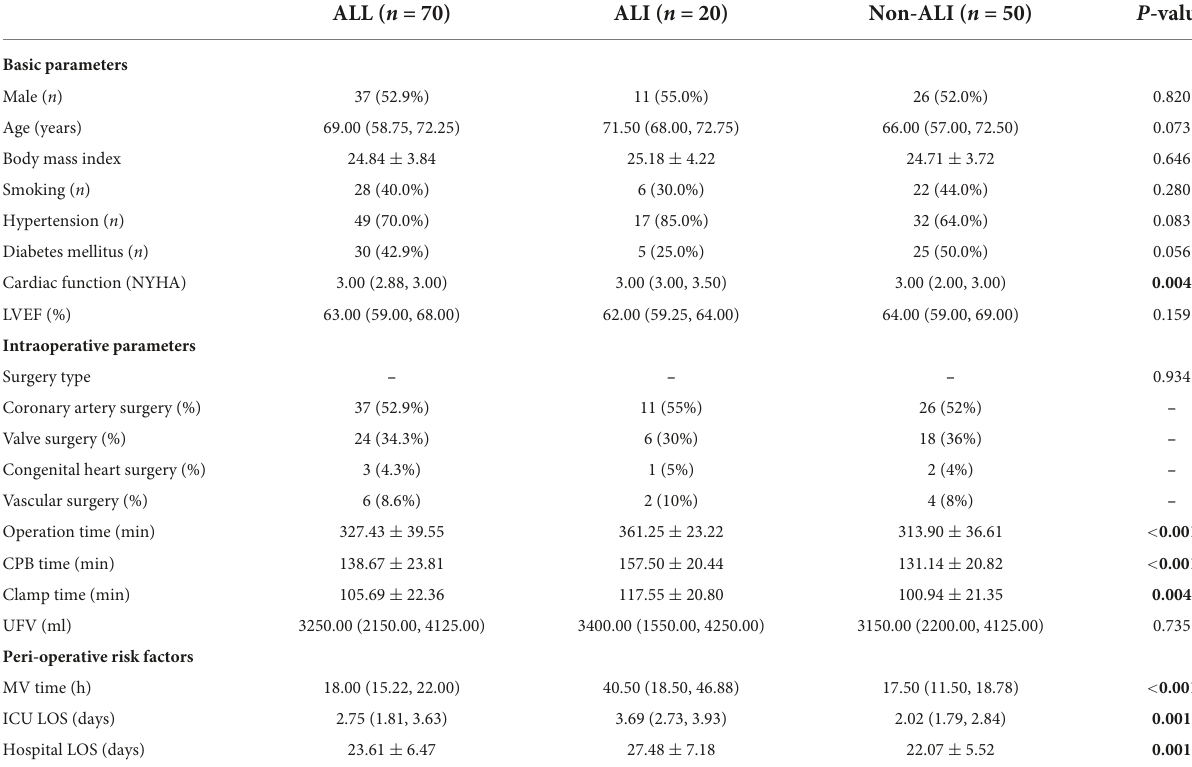
TABLE 1 Demographic and clinical characteristics of the patients enrolled in the study cohort.